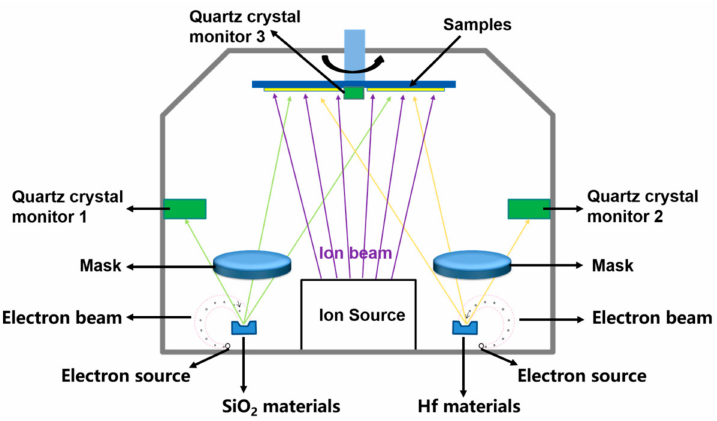
Figure 1. The schematic diagram of the ion-assisted co-evaporation